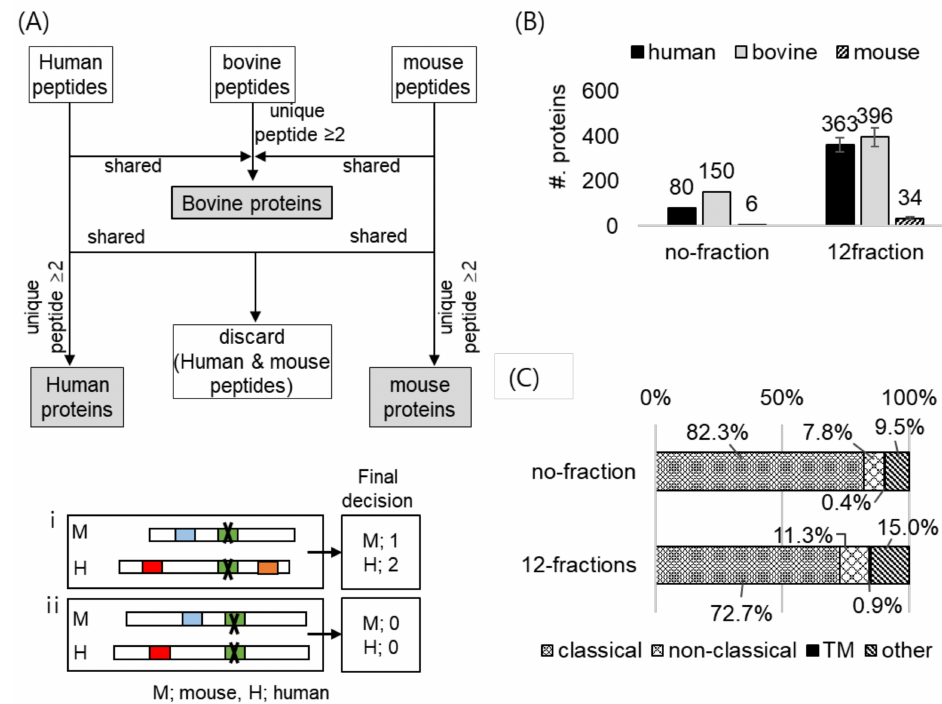
Figure 4. Investigation of any interference by cells that are co-cultured with our target cells. The transduced human CHON-002 cells were co-cultured with the xenogeneic cells, which are mouse ATDC5 cells that cannot use ANL during protein synthesis. ( A ) Schematic diagram of decision on the origin (bovine, mouse, or human) of the shared peptide (top). All shared peptides between human and mouse proteins were excluded for further analysis (bottom). In the final decision, only proteins with two or more peptides were counted. (i) it was determined that only human protein was identified. (ii) both protein determined to be unidentified. ( B ) The number of the proteins identified after applying the criteria in the analyses of single shot or high pH reversed phase fractions. With fractionation, the number of the identified human proteins increased approximately four